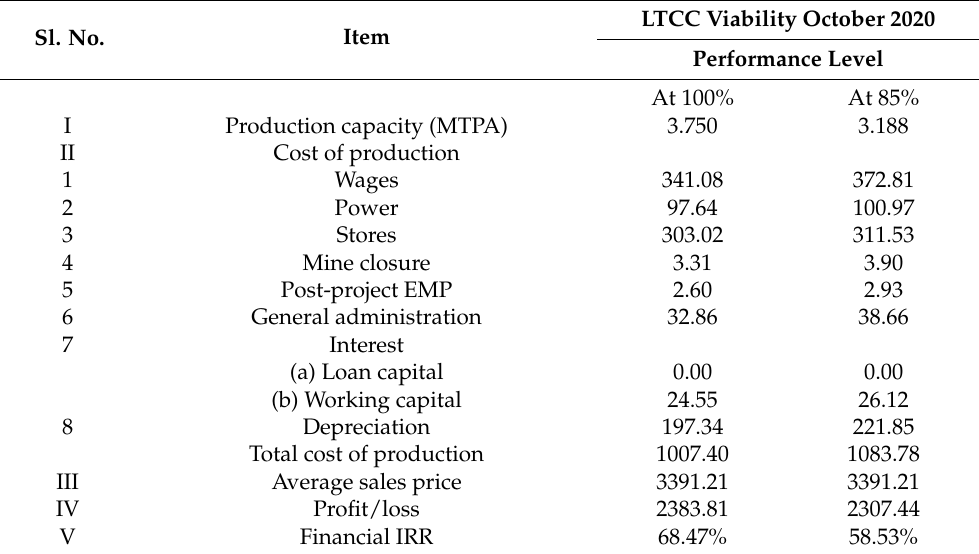
Table 9. Capital costs by SCCL for longwall in 2013 and LTCC (offered to SCCL by a Chinese